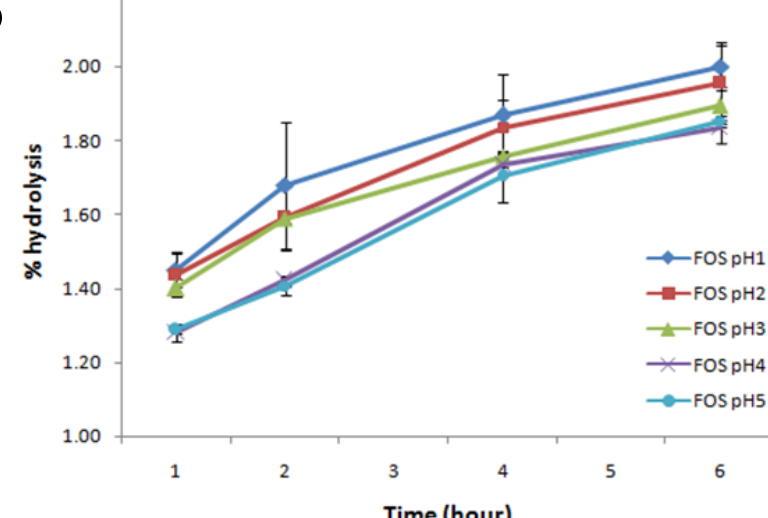
Figure 3. Degree of hydrolysis for both ( a ) FOS and ( b ) BSCP in artificial human gastric juice. ( a